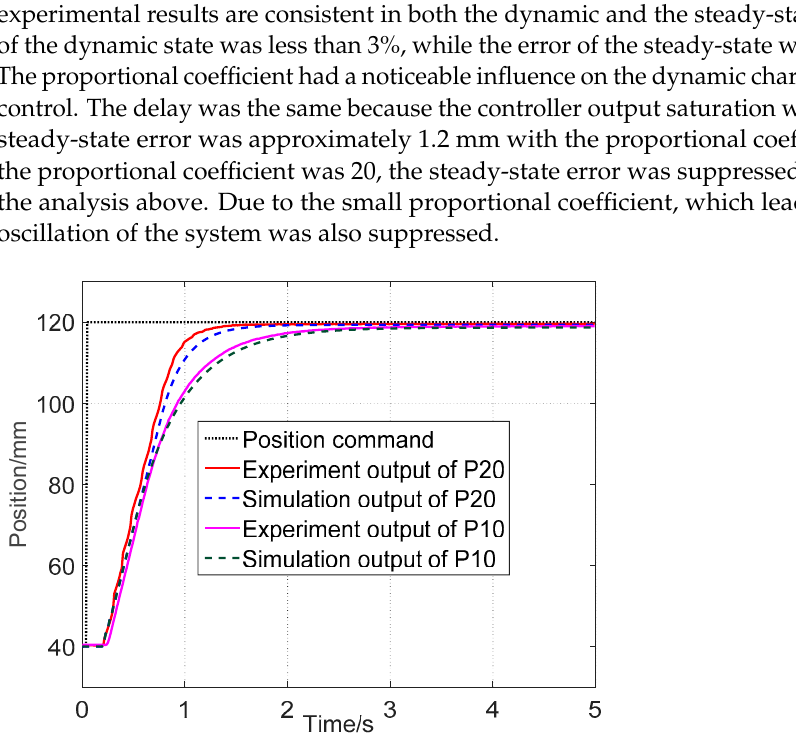
Figure 15. The results of the position in the closed-loop step simulation and the experiment with the different proportional coefficients.